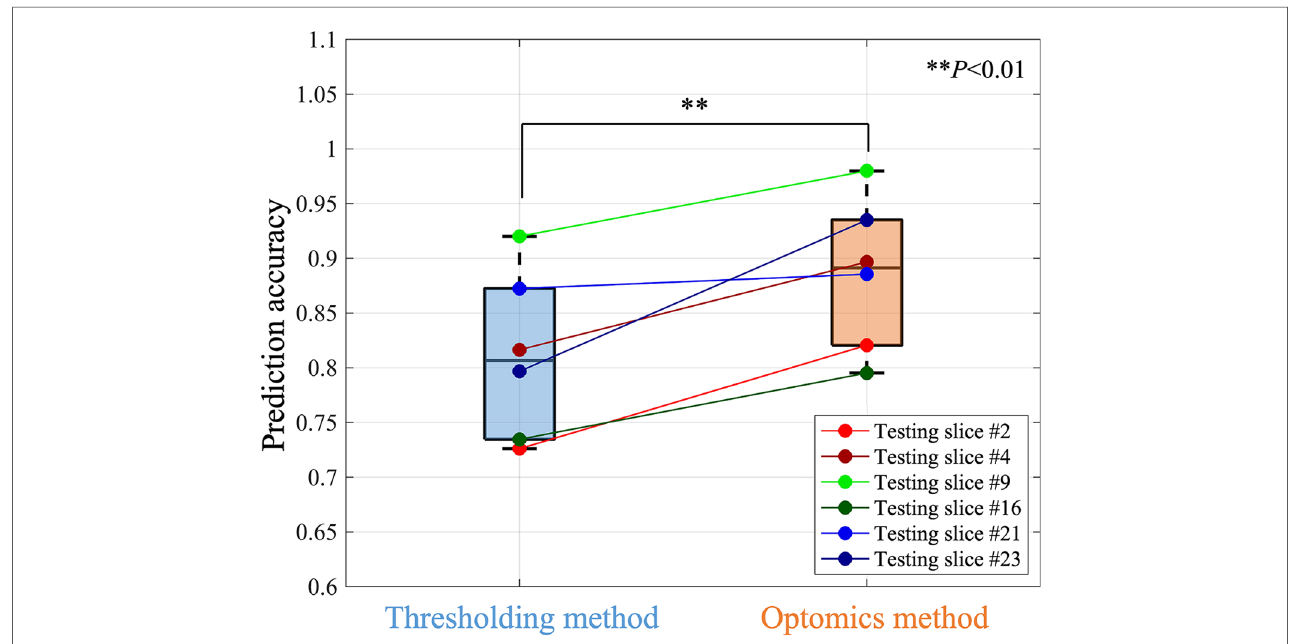
FIGURE 7 Comparison of the prediction performance of thresholding and optomics methods based on all testing slices.